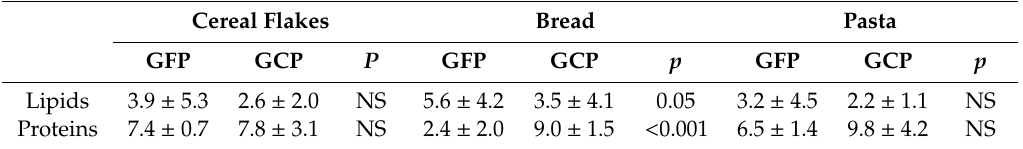
Table 1. Analytical protein and lipid content in gluten-free rendered foodstu ff s divided by food groups, compared to gluten-containing products, expressed by 100 g of foodstu ff s. Cereal Flakes Bread Pasta GFP GCP P GFP GCP p GFP GCP p Lipids 3.9 ± 5.3 2.6 ± 2.0 NS 5.6 ± 4.2 3.5 ± 4.1 0.05 3.2 ± 4.5 2.2 ± 1.1